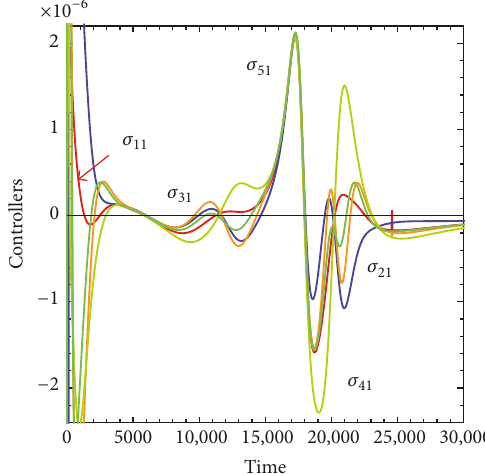
Figure 13: Translational accelerations, 𝜎 1𝑖 for Scenario 3.